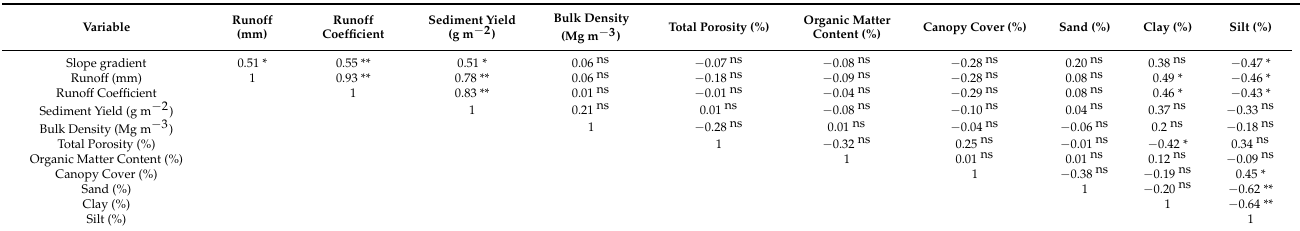
Table 3. Pearson correlation between slope gradient, runoff, runoff coefficient, sediment yield, some soil properties, and canopy cover.